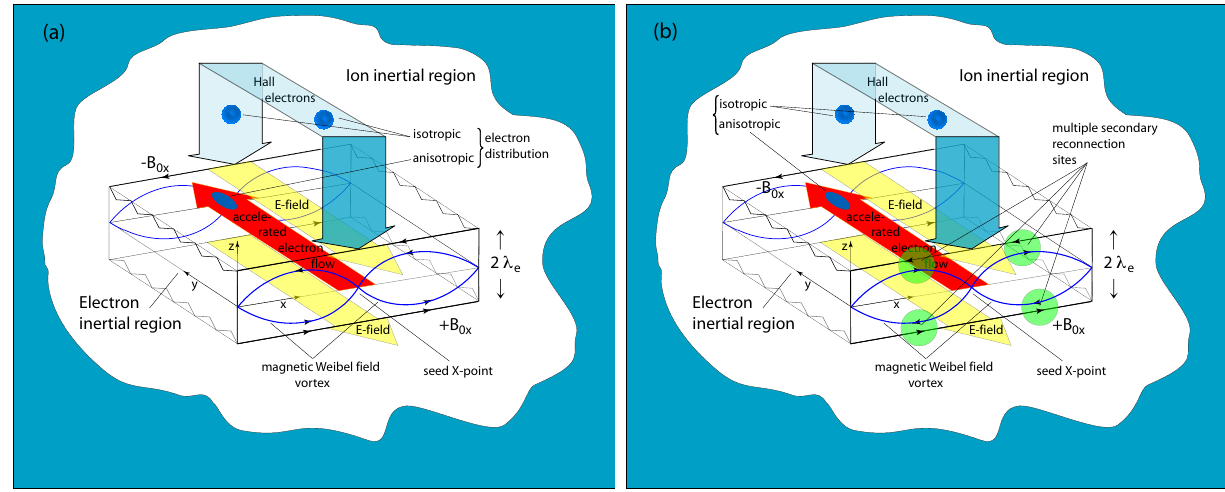
Fig. 6. Sketch of the electron-inertial region (width 1z = 2 λ e ) around the centre of the current layer, embedded into the ion-inertial region. Hall-electrons carrying the Hall-current in the ion-inertial region enter the electron-inertial region (shown on one side of the current layer only) with isotropic temperature distribution, experience the electric field E , accelerate into +ˆ y direction. After being heated by the two- stream instability they develop a temperature anisotropy and excite magnetic Weibel-vortices (blue) along ˆ x the vertexes of which serve as seed- X points for reconnection. The condition that B z = 0 at z =± λ e allows for two types of Weibel vortices: (a) a symmetric (magnetically continuous) vortex-mode (same direction as the external fields B 0 x ), and a (b) anti-symmetric non-continuous vortex-mode (antiparallel to the external field) which yields tail-current bifurcation.The anti-symmetric mode gives rise to multiple reconnection sites (shown in green colour) and presumably leads to explosive